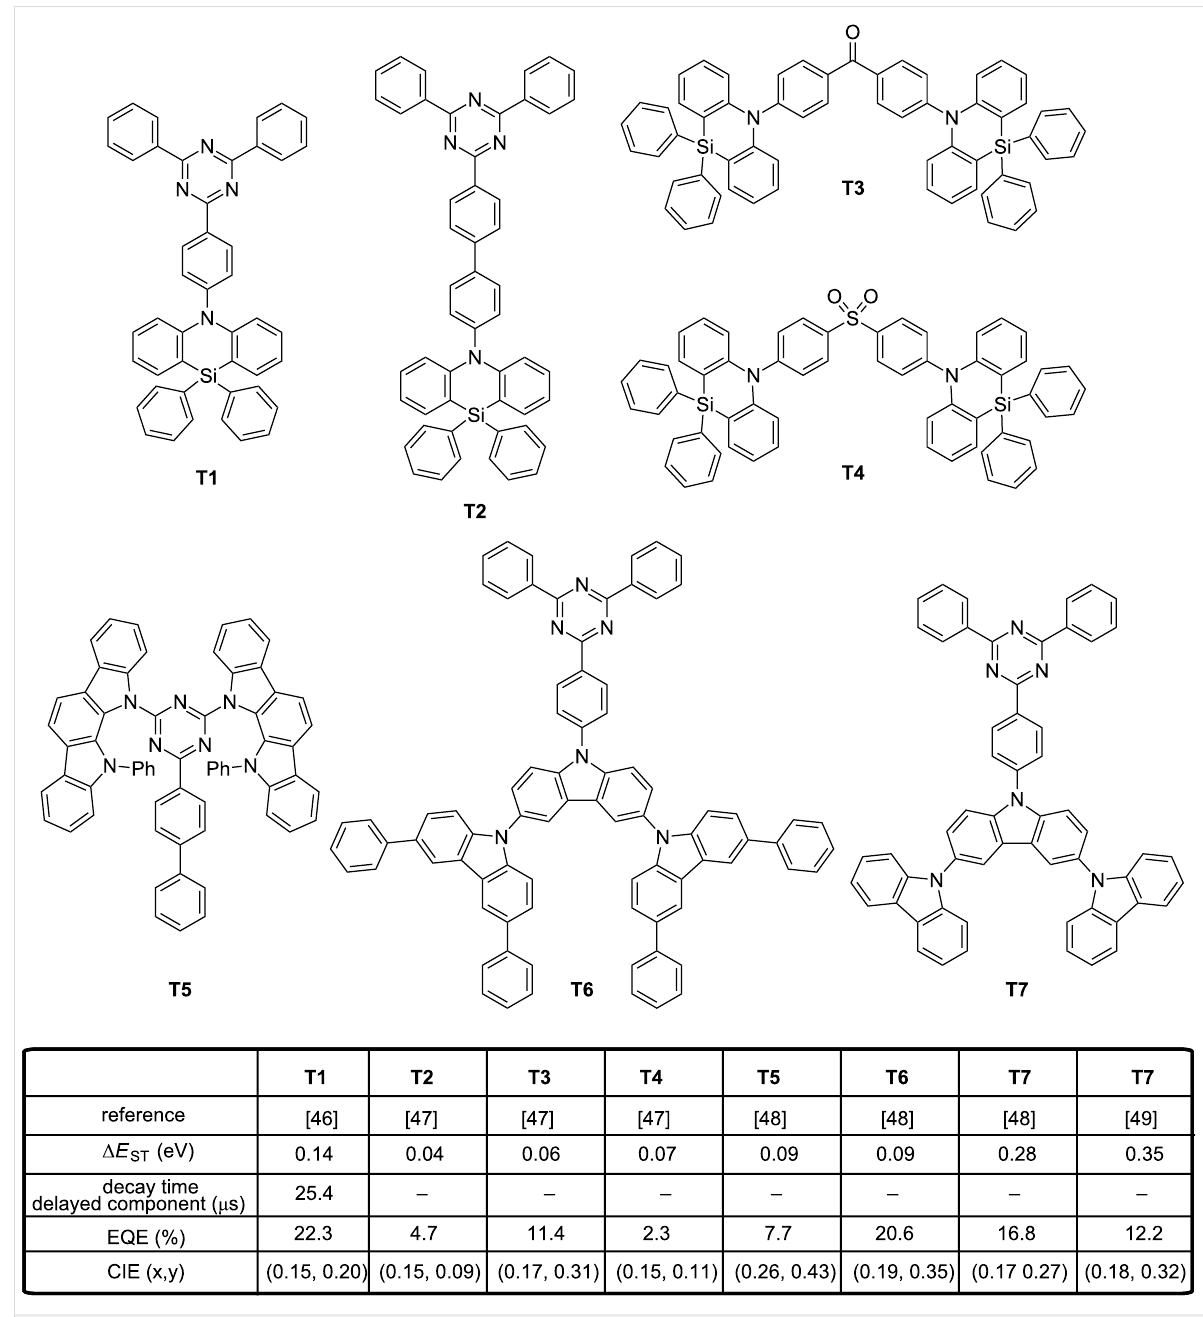
Figure 4: Triazine-based TADF emitters T1 – T3, T5 – T7 and azasiline derivatives T3 and T4 .